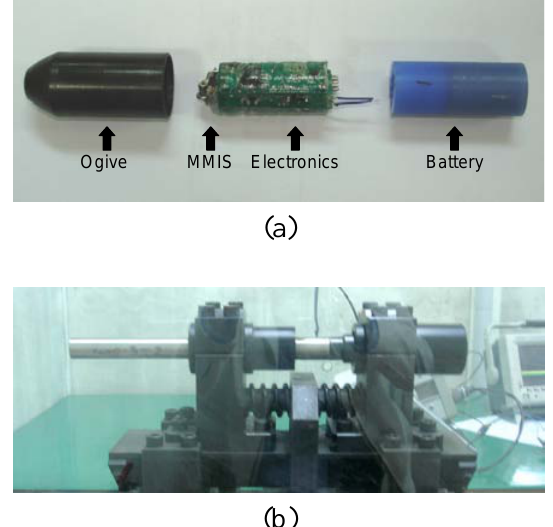
Figure. 16. Experimental setup for MMIS firing test: (a) Sample projectile with MMIS; (b) Prototype rifled gun.